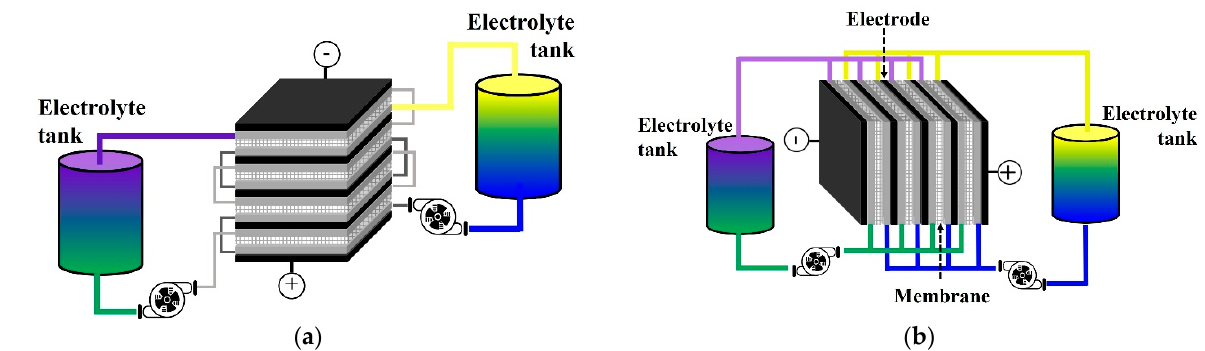
Figure 1. Flow pattern of VRFB stack . ( a ) Horizontal VRFB stack; ( b ) Vertical VRFB stack.